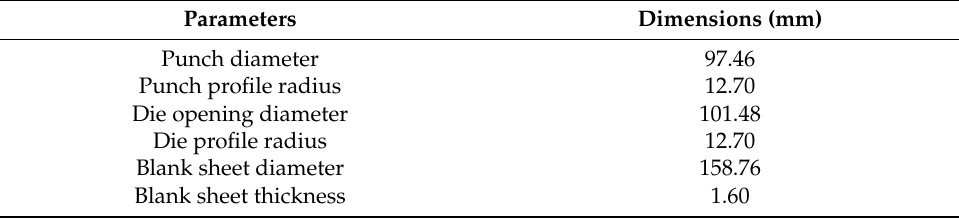
Table 2. Material properties of the blank sheets.